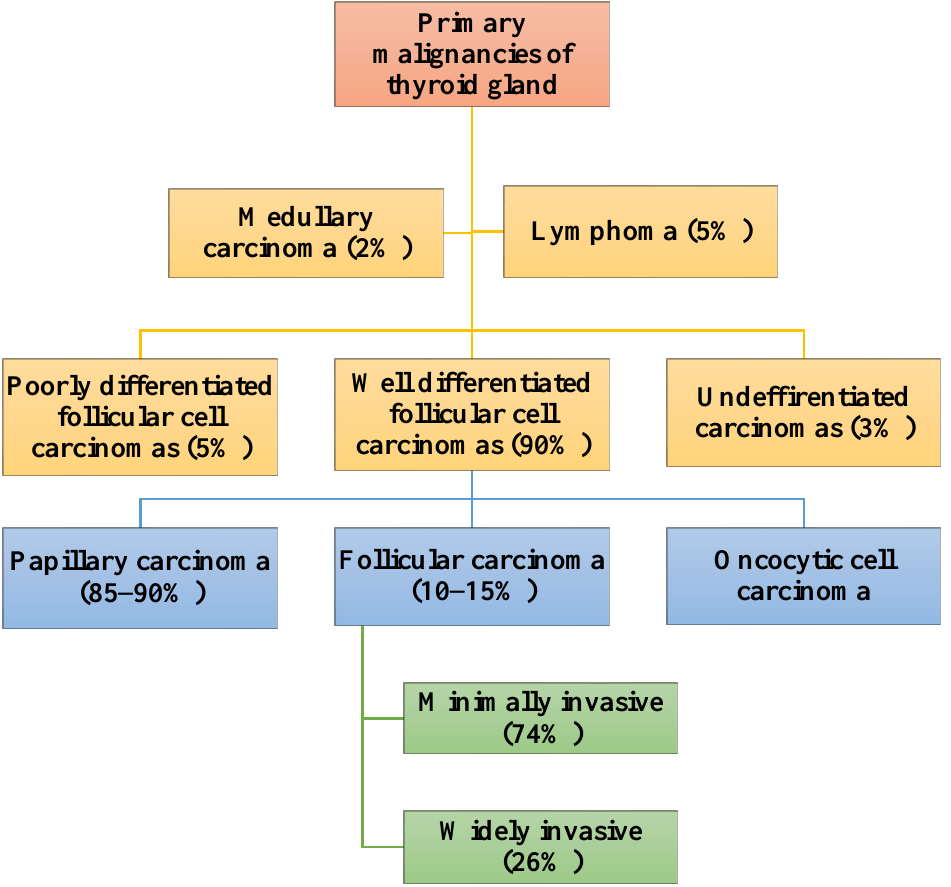
Figure 1. Classification and proportional rate of occurrence of follicular carcinoma and other thyroid malignancies.